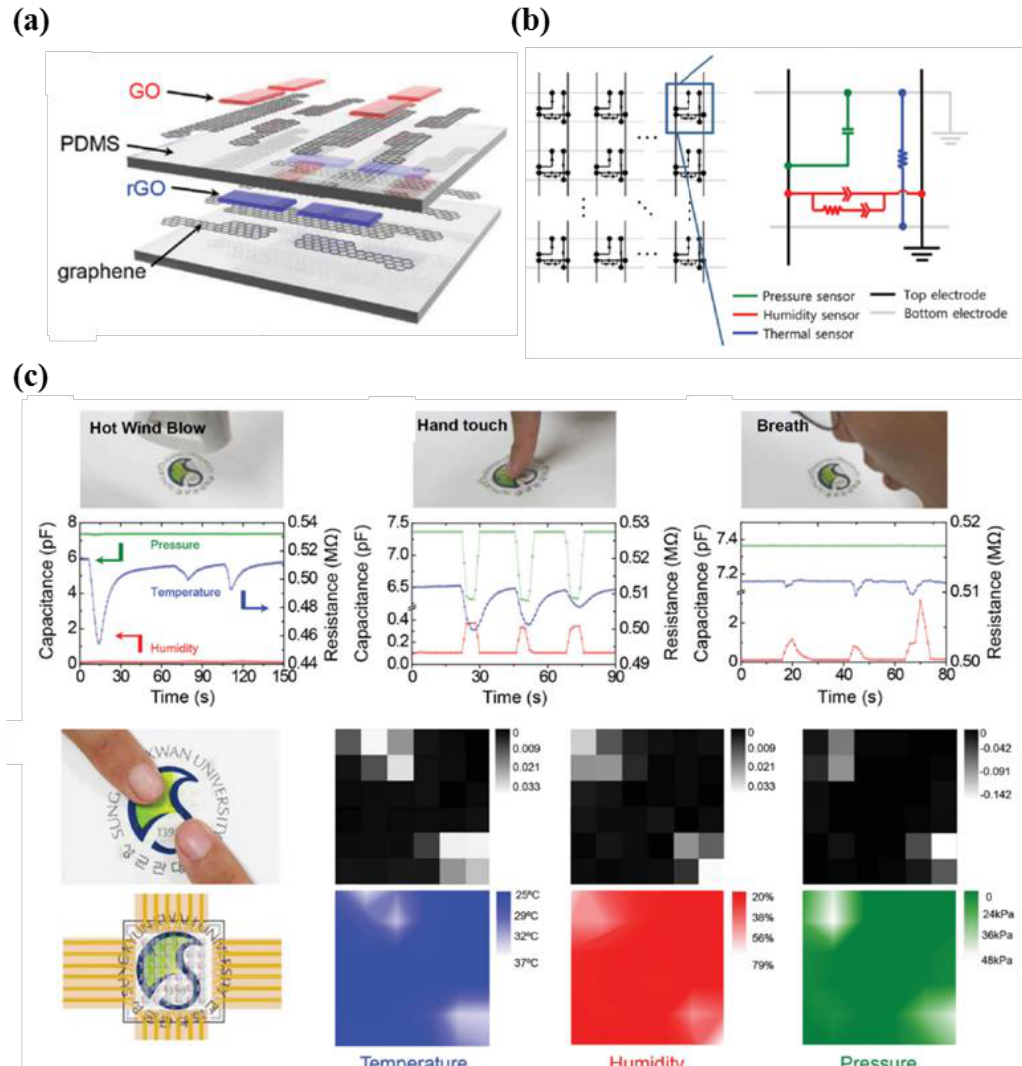
Figure 14. ( a ) Schematic illustration of multimodal E-skin sensor based on graphene material; ( b ) circuit diagram of the device; ( c ) sensing capabilities of the multimodal e-skin sensor corresponding to various stimuli (hot wind blow, hand touch, and breath) (reprinted with permission for Figure 14a–c from Ref. [138] Copyright 2016 John Wiley and Sons).